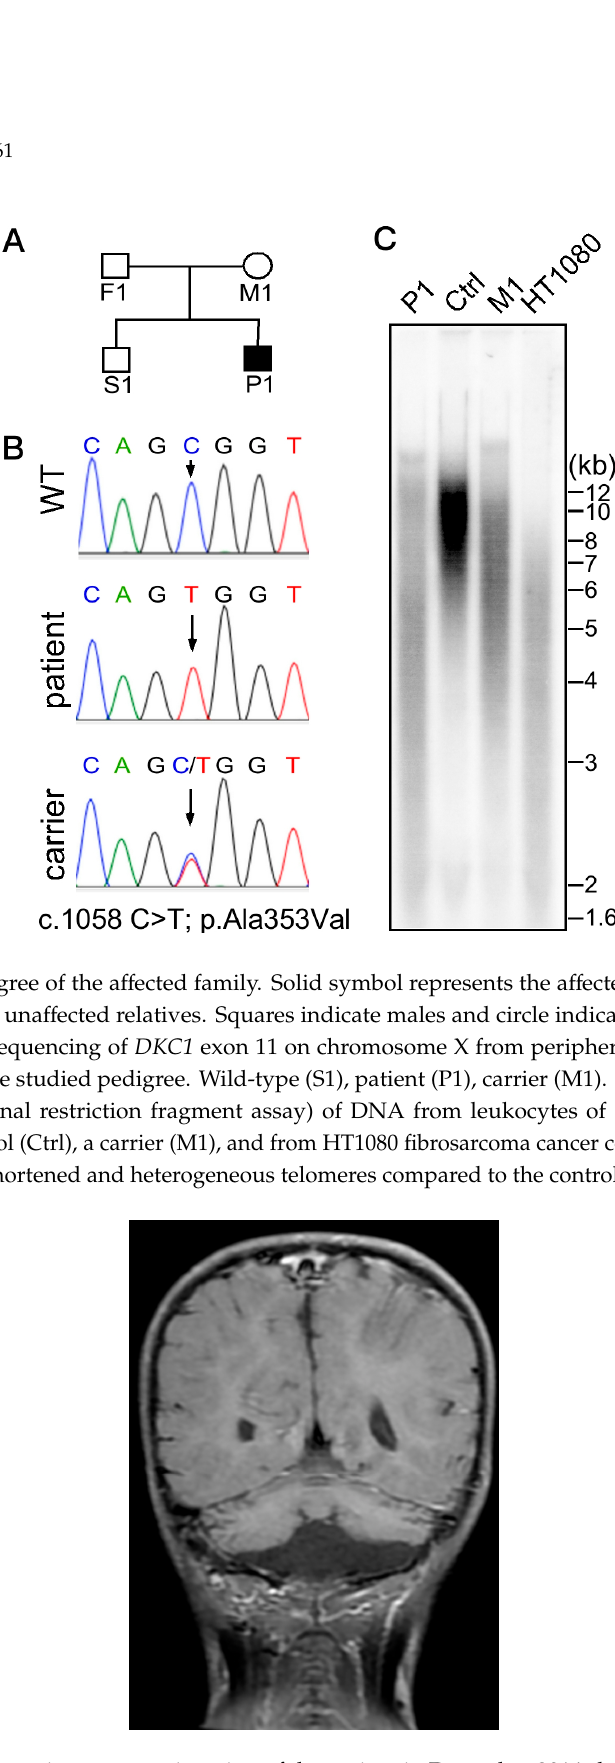
Figure 3. Pre-transplant photographs of the patient showing nail dysplasia ( A ), abnormal skin pigmentation ( B ), and tongue leukoplakia (white arrowhead) ( C ). As HLA-identical sibling donors were unavailable, a decision was made to pursue unrelated HSCT as salvage therapy. The conditioning consisted of alemtuzumab (a total of 1 mg/kg given from day − 10 to day − 6) and fludarabine (30 mg/m 2 daily from day − 8 to day − 3), kindly provided by Boston Children’s Hospital [8]. For prophylaxis against graft-versus-host disease (GVHD), the patient received cyclosporine and mycophenolate mofetil. On 10 March 2015 (day 0), he received PBSCs from an unrelated donor comprising 45 × 10 8 total nucleated cells/kg and 23 × 10 6 CD34+ cells/kg. The patient and the donor were HLA-8/8 matched (A 1101/2402, B 4001/4601, Cw 0102/0702, DR 0809/0901) and ABO-matched (B to B). Neutrophil engraftment was documented on day +11. The patient did not require any transfusion after day +18. Chimerism analyses were performed from bone marrow (nine months post-transplantation) and from peripheral blood (repeatedly from day +27), all of which showed 100% donor chimerism.